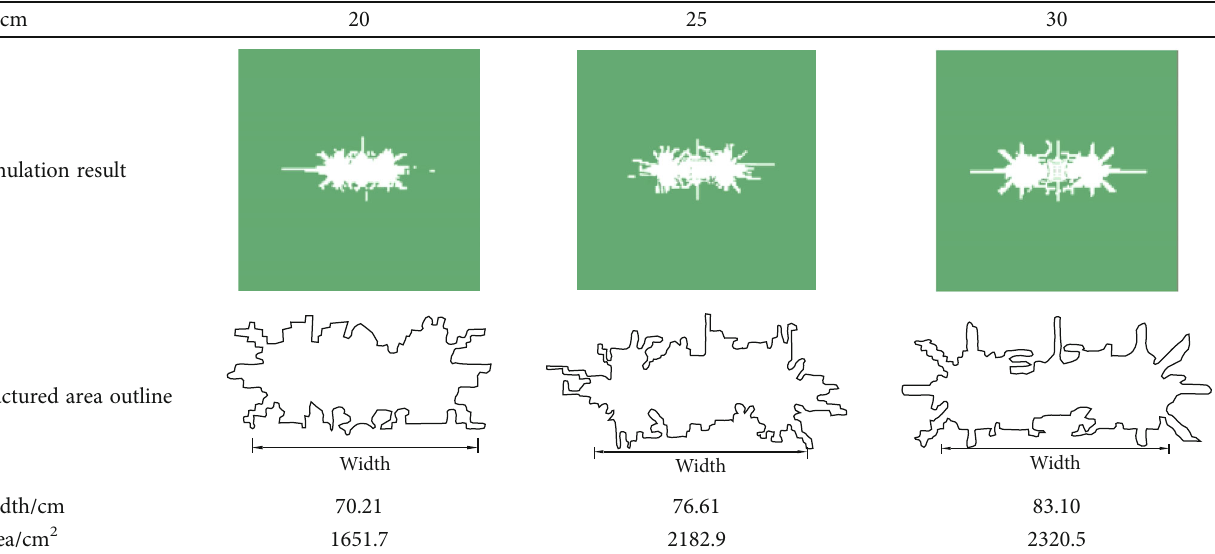
Table 6: Rock failure range under the distance between the fi rst blast hole and the empty hole.